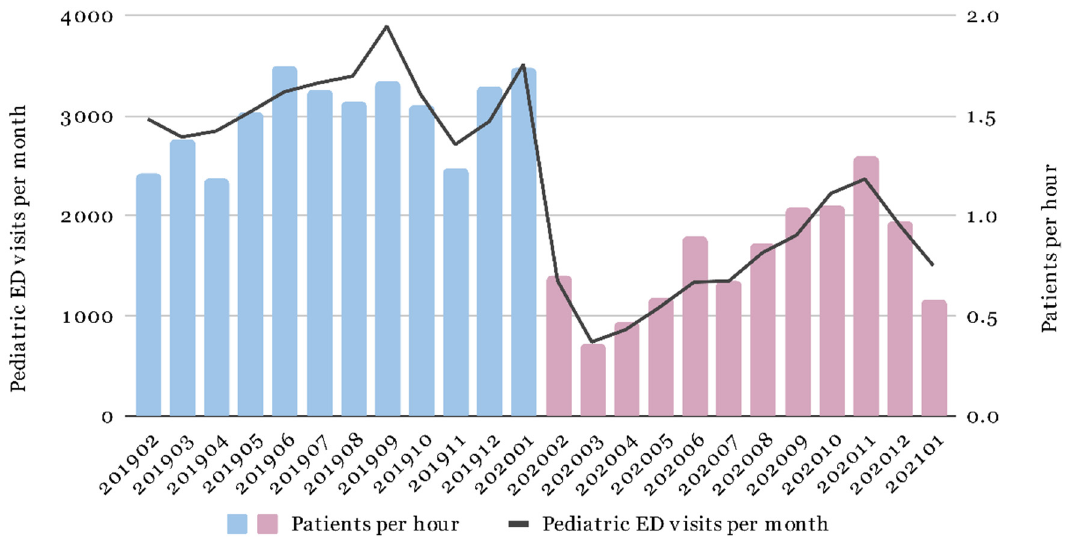
Figure 1. Pediatric patient volume and patients per hour (PPH) seen by EM residents in the pre- epidemic and epidemic periods.